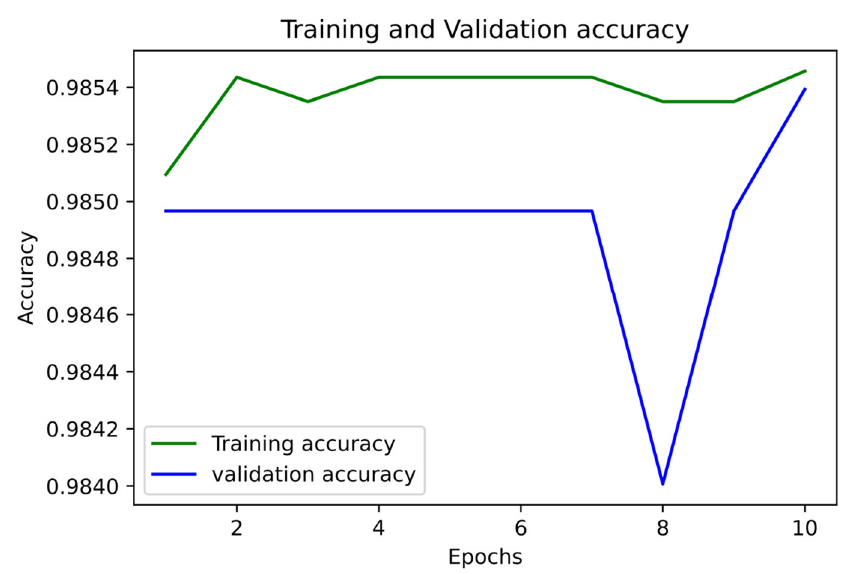
Figure 5. Accuracy Plot for Mortality Prediction.